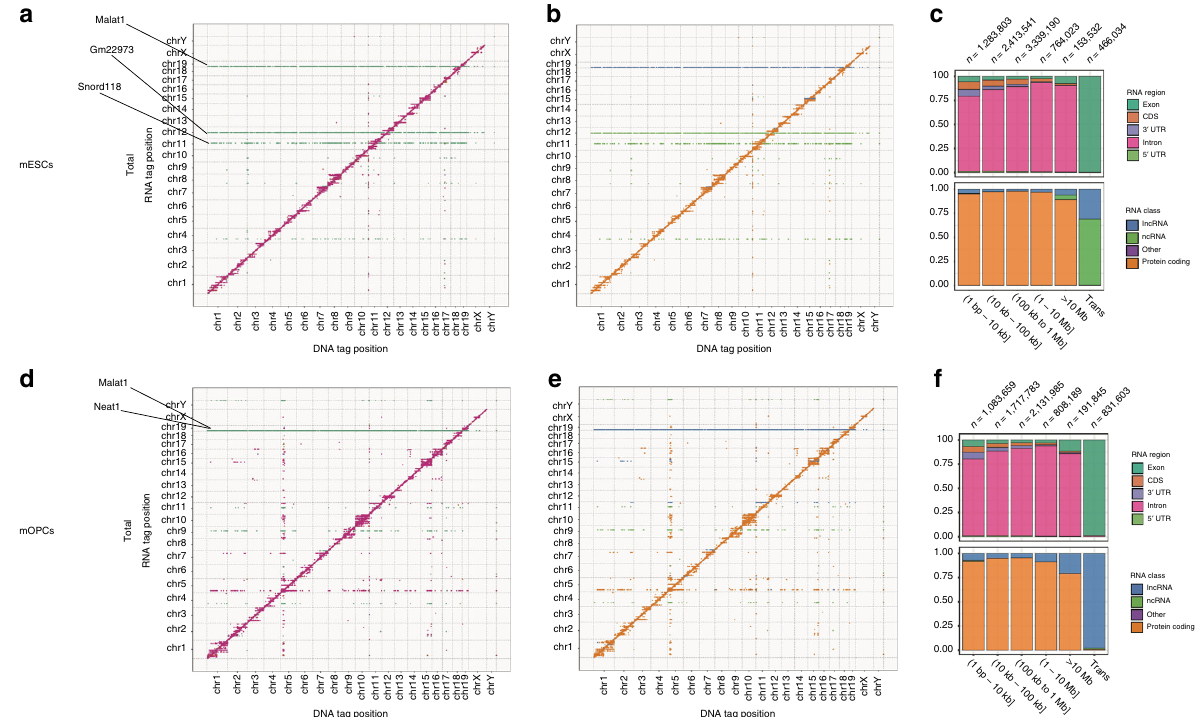
Fig. 3 RADICL-seq identi fi es genome-wide RNA – chromatin interactions. a , b RNA – DNA interactions in mESCs shown as a single point per 25-kb bin and colored (see key in c ) by the most-represented RNA region or RNA class, respectively, in that bin. c RNA – DNA interactions in mESCs, quanti fi ed according to genomic distance between RNA and DNA tags. d , e RNA – DNA interaction matrix for mOPCs, similar to that shown in a , b . f RNA – DNA interactions in mOPCs, quanti fi ed according to genomic distance between RNA and DNA tags. All panels were generated using signi fi cant total